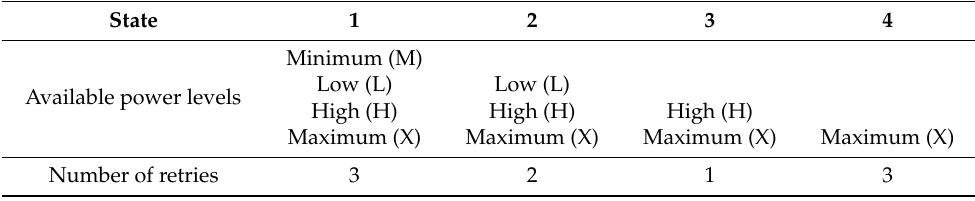
Table 2. State transition matrix when state levels go up [12,13].